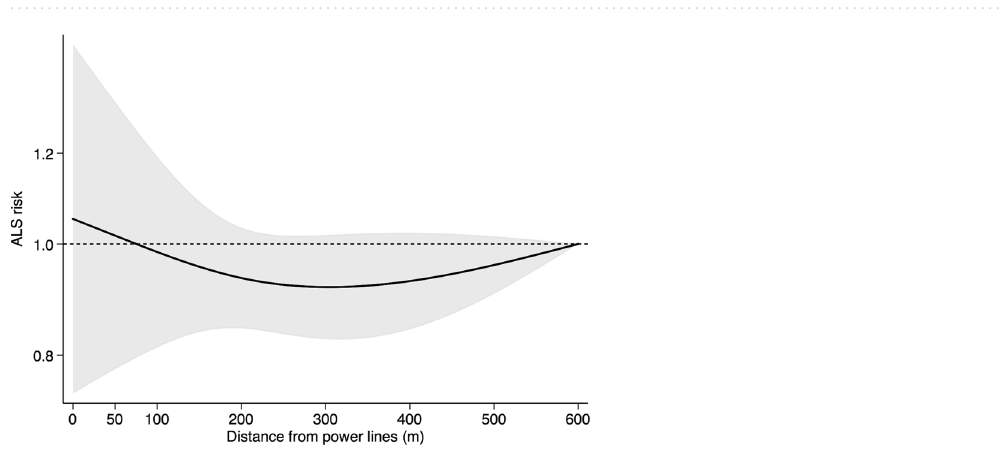
Figure 3. Dose–response meta-analysis of ALS risk according to decreasing residential distance from power